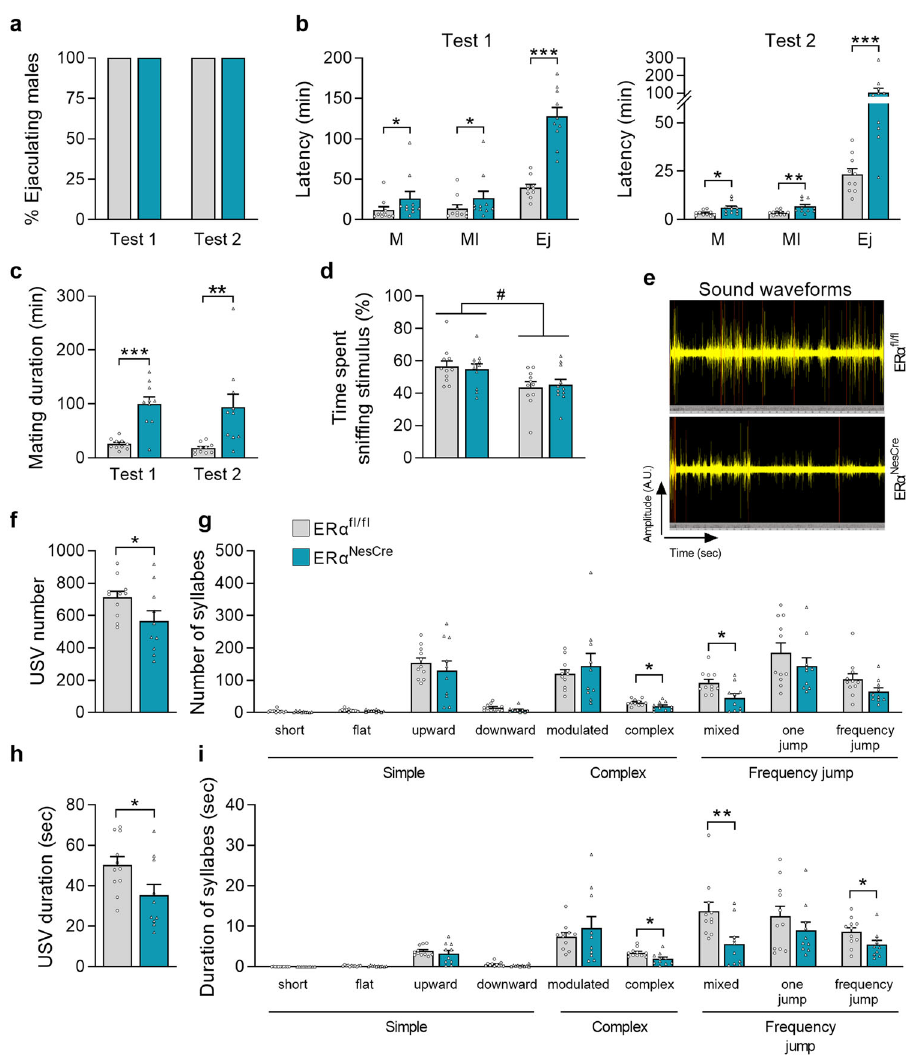
Fig. 3 The effects of neural ER α NesCre deletion on sexual behavior in males. a Percentage of control (ER α fl / fl ) and mutant males (ER α NesCre ) reaching ejaculation in tests 1 (naive animals) and 2 (sexually experienced). Data are shown as percentages. b Latencies to mount (M), intromit (MI) and to reach ejaculation (Ej) for control and mutant males ( n = 10 per genotype) on Test 1 and Test 2. Signi fi cant differences between the two genotype are indicated; * p < 0.05, ** p < 0.01, *** p < 0.001 versus controls. c Mating duration from the fi rst mount to ejaculation was higher in mutant males (*** p < 0.001 and ** p < 0.01 in Tests 1 and 2, respectively) ( n = 10 per genotype). d Olfactory preference of sexually experienced control and mutant male mice ( n = 11 per genotype), expressed as the percentage of total time spent snif fi ng the stimuli. The stimulus effect (# p < 0.05) is indicated. e Representative sound waveform for control and mutant males in the presence of a sexually receptive female during a 4-min test. f , g Total number of emitted ultrasonic vocalizations USV ( f ) and number of each syllable ( g ) produced by sexually experienced males ( n = 10 – 11 per genotype). h , i Total duration of emitted USV ( h ) and duration of each syllable ( i ). * p < 0.05, or ** p < 0.01 versus controls ( n = 10 – 11 per genotype). Instead stated otherwise, data are shown as means ± S.E.M. with individual